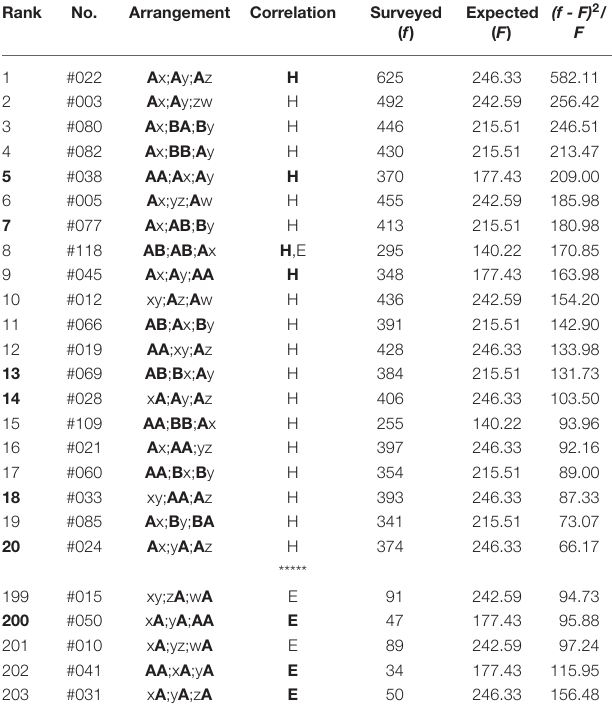
TABLE 10 | The top-twenty and the bottom-five arrangements in the latter three phrases (5-7-7) of poems in The Twenty-One Collections of Waka , wherein there are 33692 tanka poems